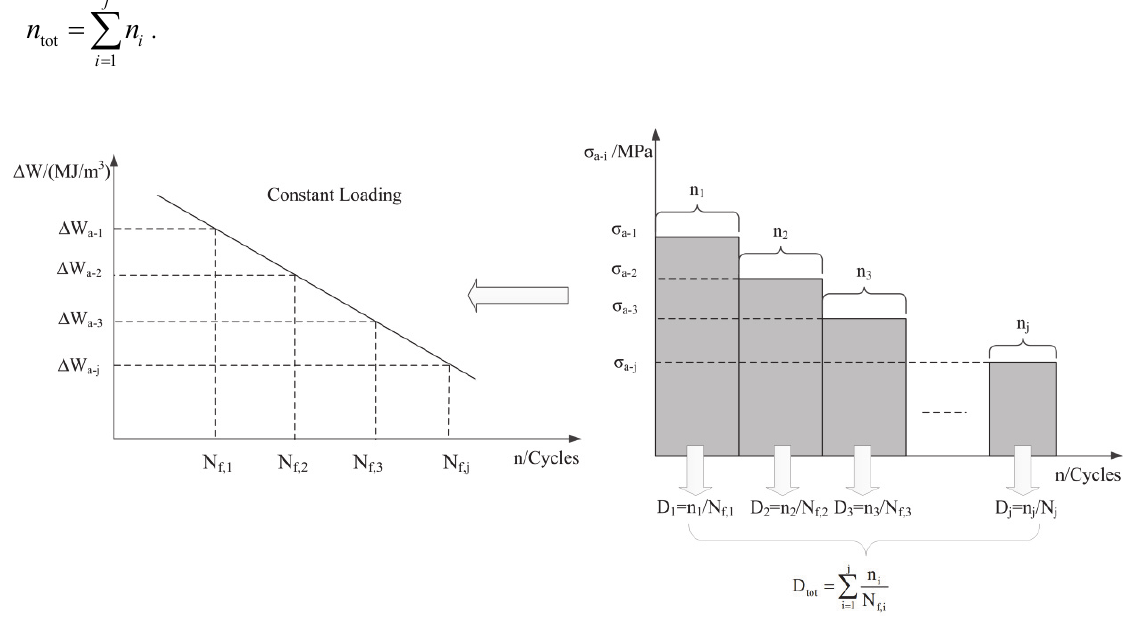
Figure 4 : Estimation of the fatigue lifetime under VA loading by